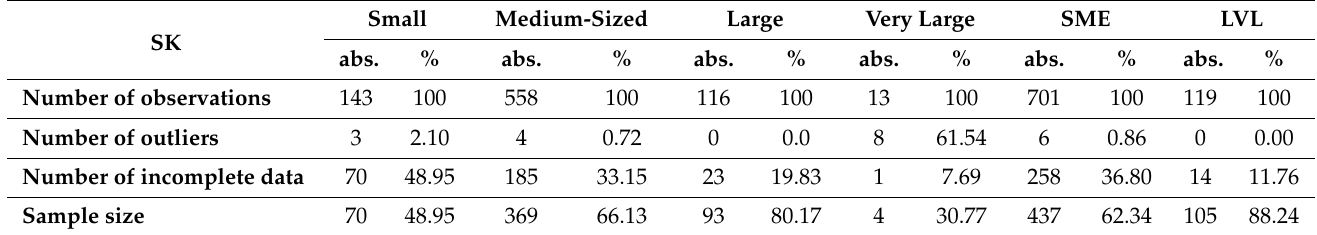
Table 8. The final sample of the Slovak companies in the transport sector.